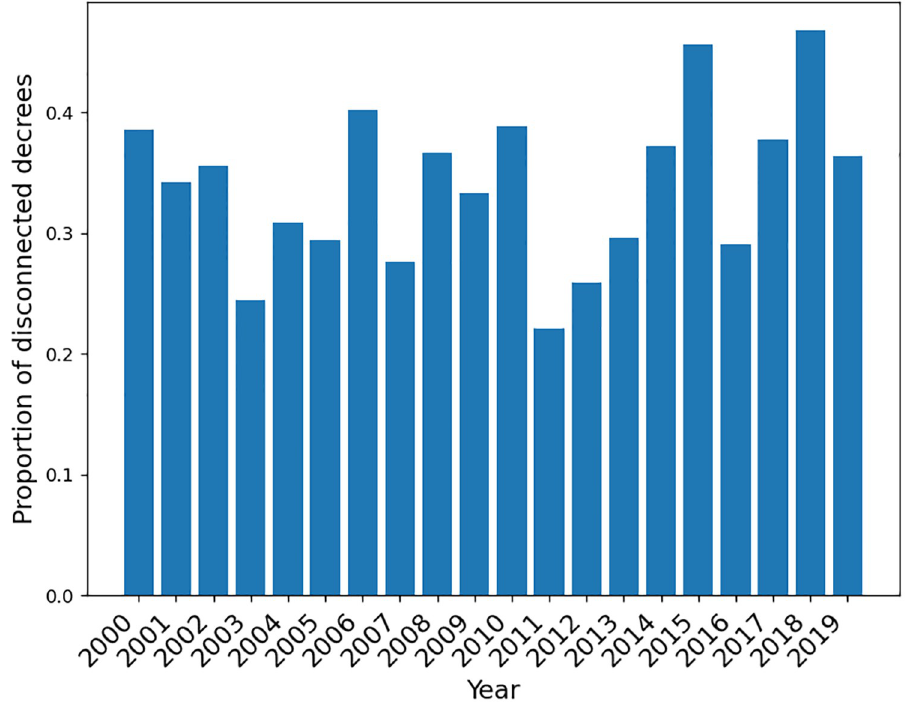
Fig 11. Disconnected decrees per year. Proportion of disconnected decrees given by (number of disconnected decrees) � (total number of decrees in a year).